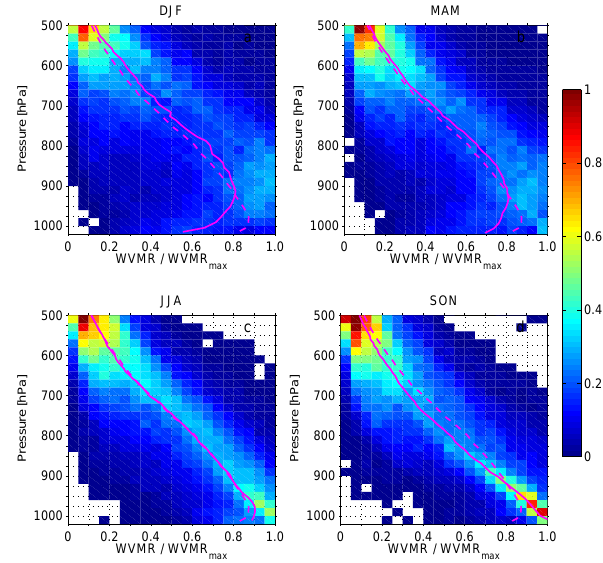
Fig. 9. Same as in Fig. 8, but for Barrow radiosoundings from Jan- uary 2003 to October 2009.